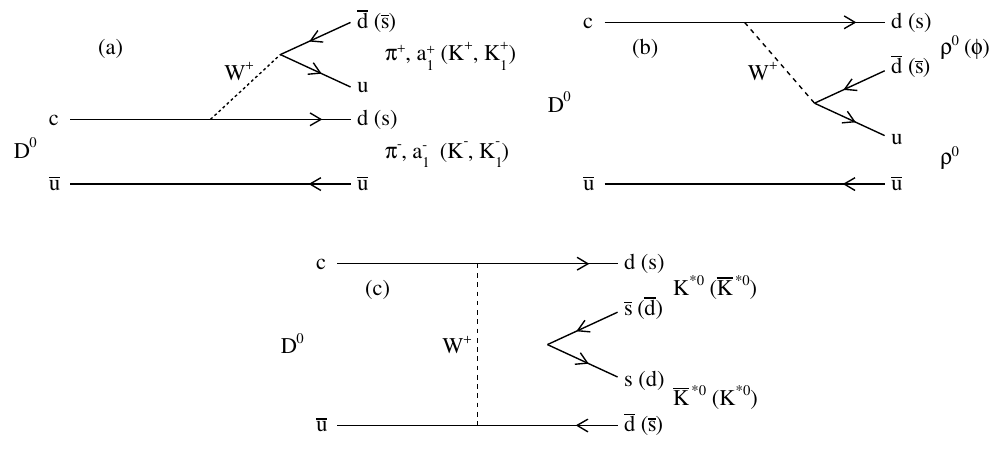
Figure 1 . Examples of the color-favored (a), color-suppressed (b) and W -exchange (c) diagrams that contribute towards the resonant structure in D 0 ! (cid:25) + (cid:25) (cid:0) (cid:25) + (cid:25) (cid:0) and D 0 ! K + K (cid:0) (cid:25) + (cid:25) (cid:0)